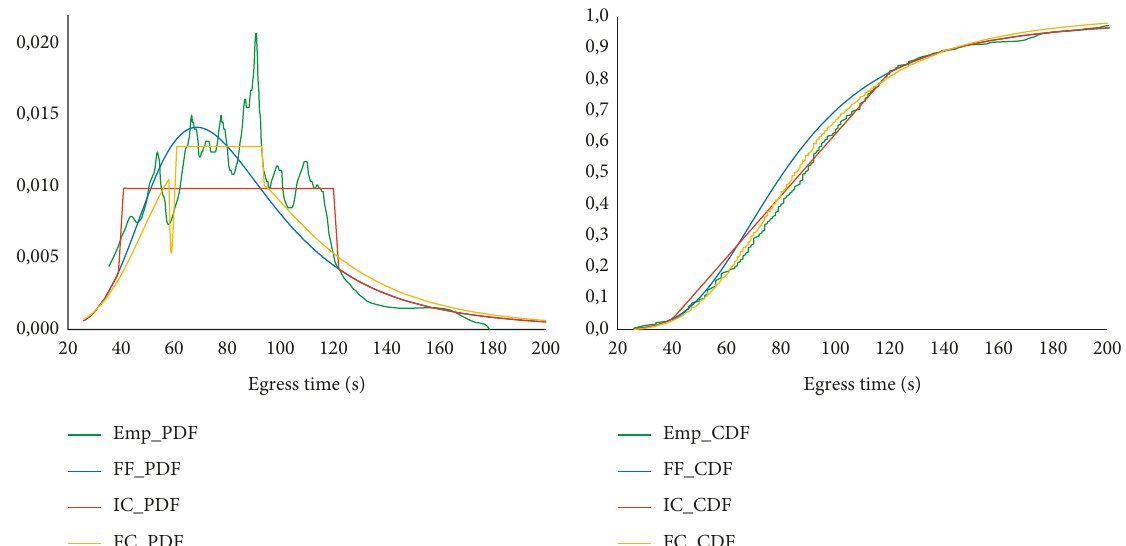
Figure 8: PDF (a) and CDF (b) of egress times for the train at 18:46: